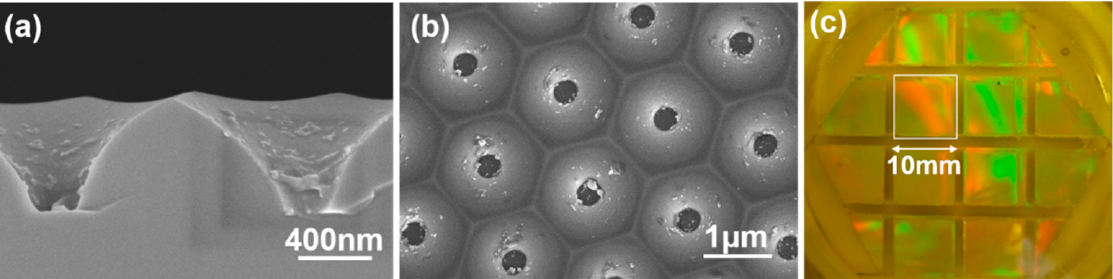
Figure 1. ( a ) Cross ‐ sectional and ( b ) top views of the morphologies of a two ‐ inch sapphire substrate. ( c ) The Al ‐ coated sapphire substrate with heat ‐ resistant tape.